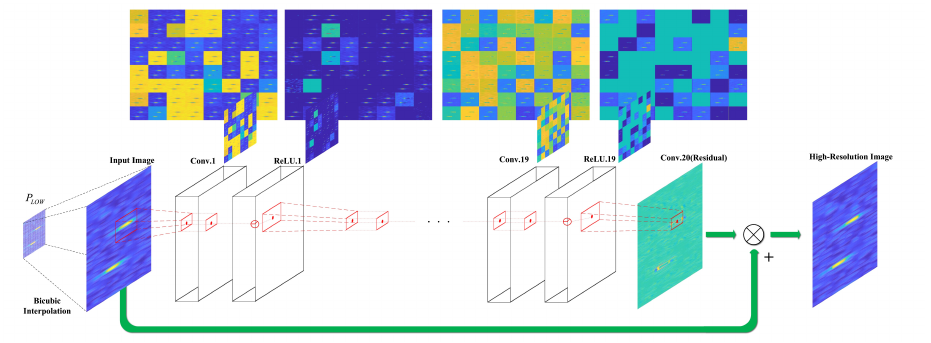
Figure 5. The structure of VDSR.